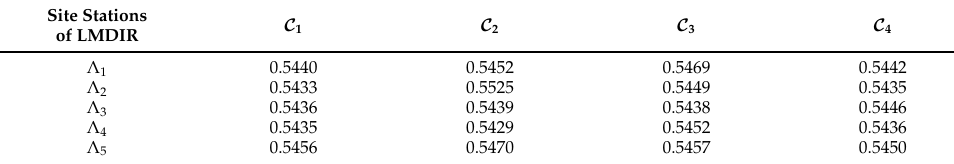
Table 3. Utility group assessment matrix U = [ ˙ u kl ]